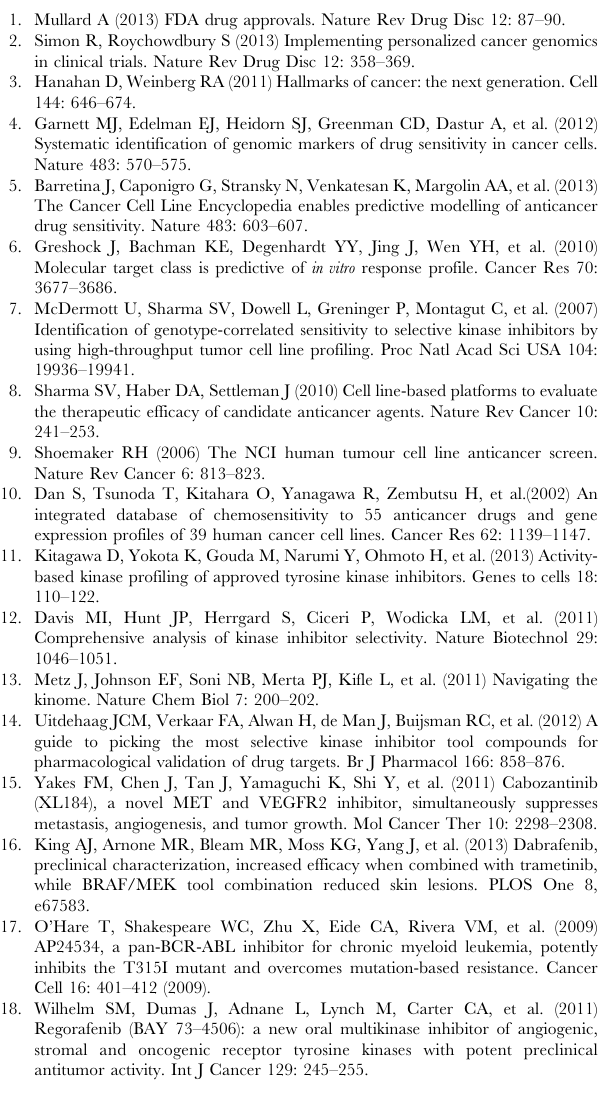
Figure S8 Selectivity entropy (S sel ) can be estimated on basis of single concentration data. Table S1 Names and sources of approved kinase inhibitor drugs used in this study. Table S2 Frequency of point mutations in validated cancer genes in the cell panel. Table S3 List of genes mutated in the Oncolines panel that have been used to investigate drug sensitivity. Table S4 Statistical power analysis to determine cutoff levels for significance in the cell line panel. Table S5 IC 50 s of 25 kinase inhibitors on 44 cell lines.